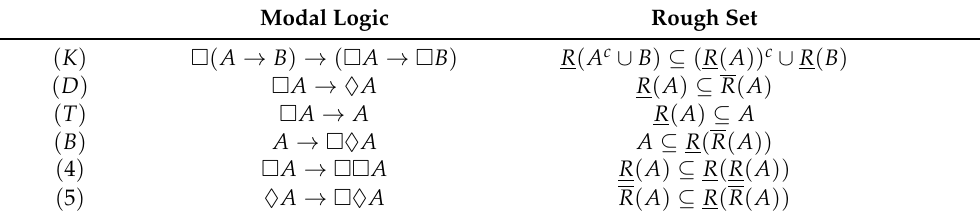
Table 1. Schemas K , D , T , B , 4 and 5 in modal system and rough set, respectively. Modal Logic Rough